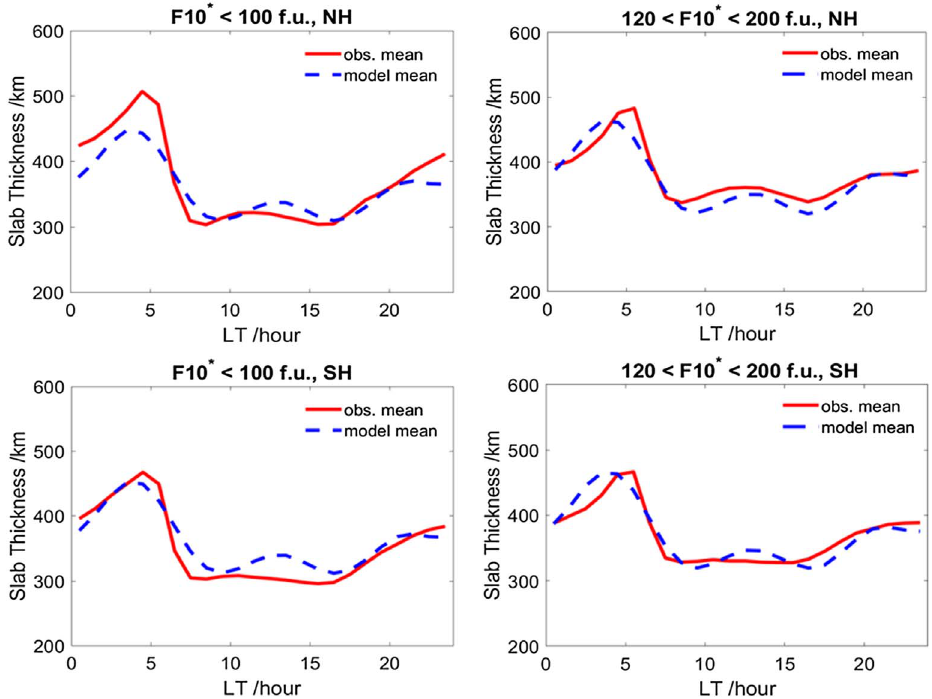
Fig. 4. Diurnal behavior of the equivalent slab thickness at LSA ( F 10* < 100) and HSA (120 < F 10* < 200) conditions averaged over Northern (NH) and Southern hemispheres